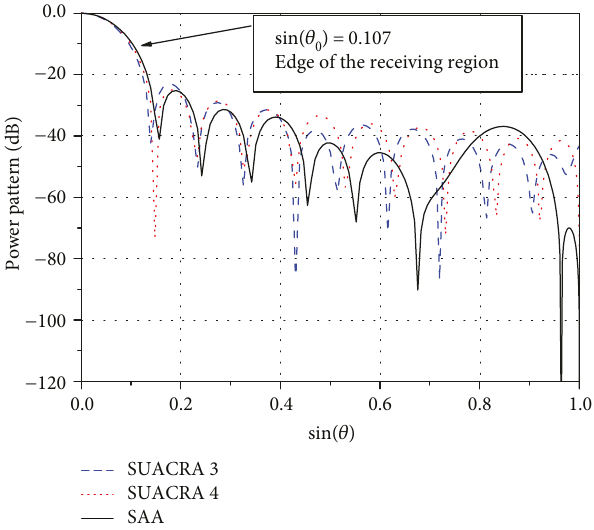
Figure 9: Power patterns ( φ =0) comparison of SUACRA 3, 4 and the SAA.